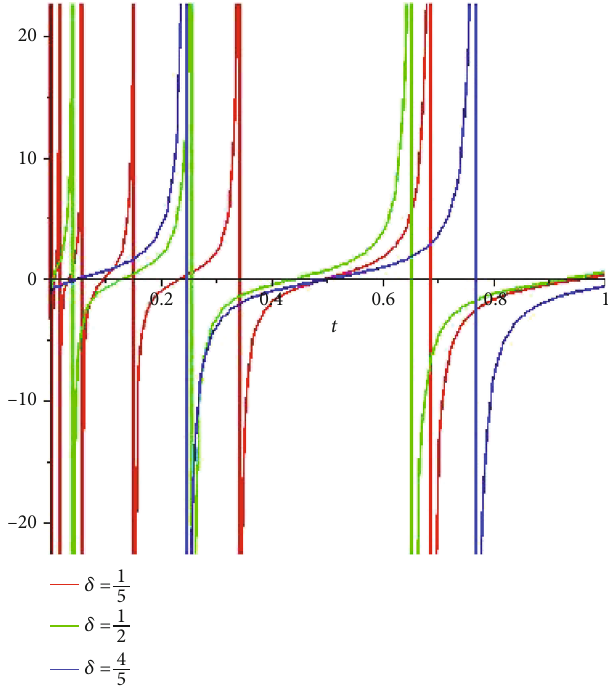
, x Þ at x = 1 : 0 in Equation (41) for di ff erential values of the fractional parameter Figure 8: The positive real part of u 3 1 ð t